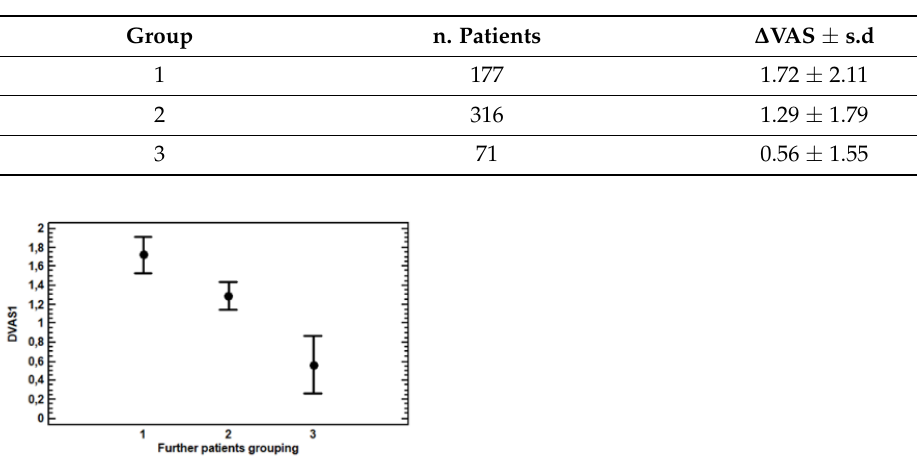
Figure 5. Plot of average values of ∆ VAS and standard error of the three groups of patients grouped according to the number of alleles conducive to pain reduction after one month of treatment with cannabis.